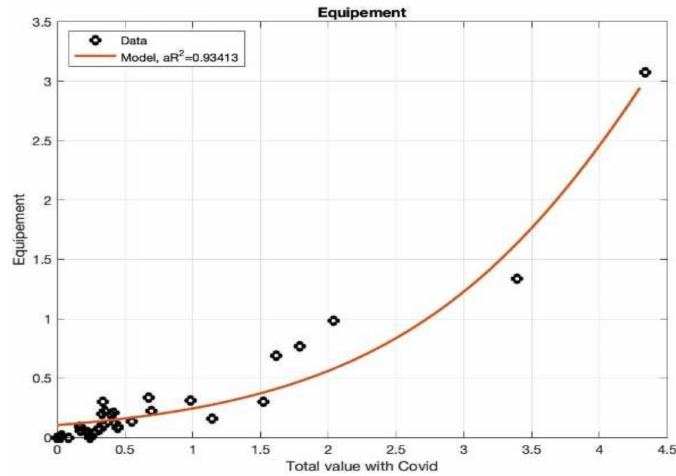
Figure 11. Correlation relationship of total COVID funding vs. equipment.